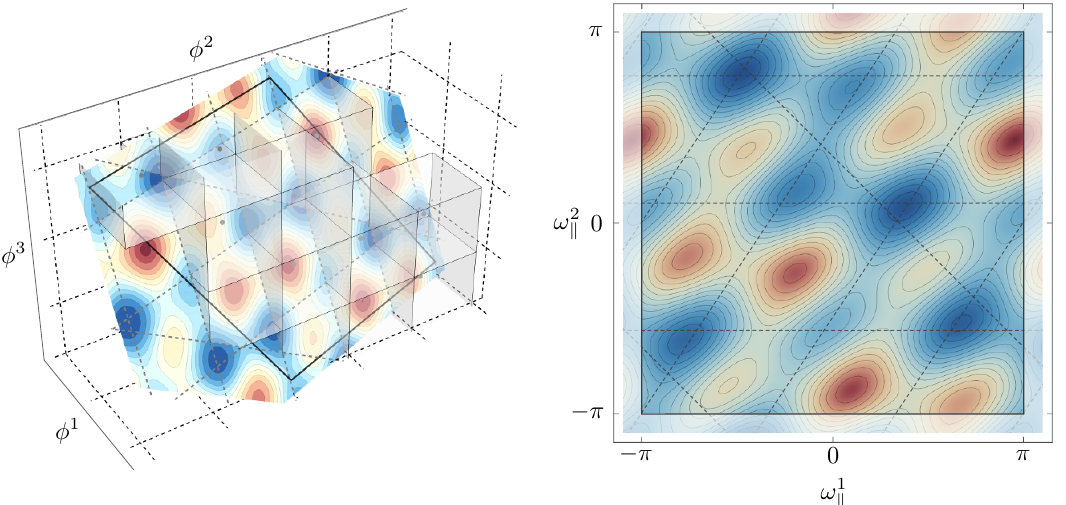
Figure 2 . Left : contour plot of the auxiliary potential on the constraint surface (cid:6) in (cid:30) -coordinates, for an example with N = 2 ; P = 3. The solid black lines denote one periodic domain of the potential, while the dashed gray lines denote the boundaries of the tiles de(cid:12)ned in (2.7) (the intersections of the cubical tiling (2.6) of the auxiliary potential with the constraint surface). The depicted cubes constitute a full set of those with distinct intersections with (cid:6). Right : contour plot of the physical potential and its tiles in aligned coordinates ! (de(cid:12)ned later in (2.18)). Opposing boundaries of k the periodic domain are